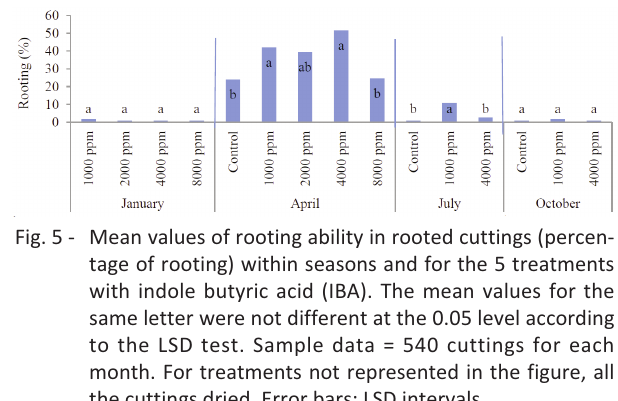
tage of rooting) within seasons and for the 5 treatments with indole butyric acid (IBA). The mean values for the same letter were not different at the 0.05 level